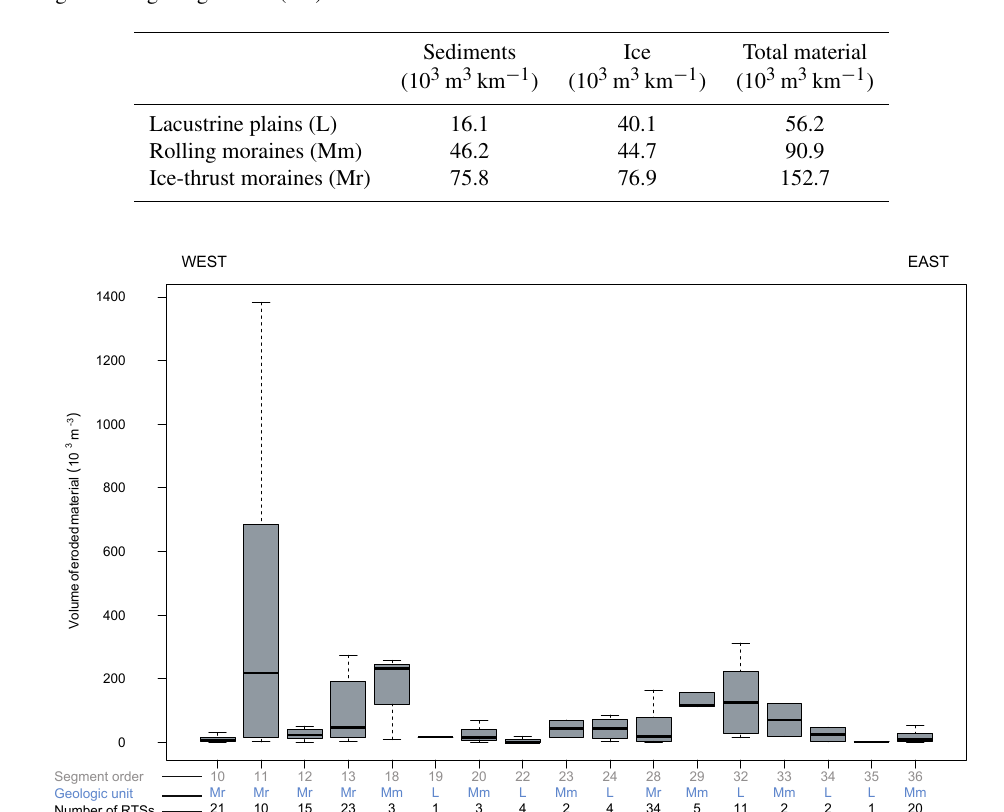
Table 1. Volume of material, including ice and sediments, eroded by RTSs along the Yukon Coast per geologic unit. The values are normalized to the shoreline length of the geologic units (km).